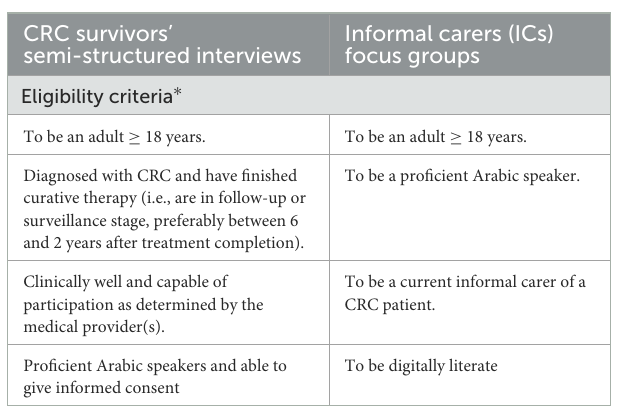
TABLE 1 Eligibility criteria for CRC survivors’ interviews and ICs’ focus groups.